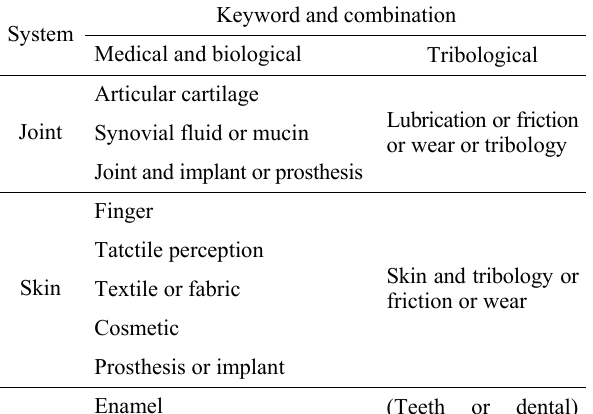
Table 1 Keywords and combinations for search in Web of Science, modified/taken from Ref. [1]. Reproduced with permission from Ref. [1], © The author(s),